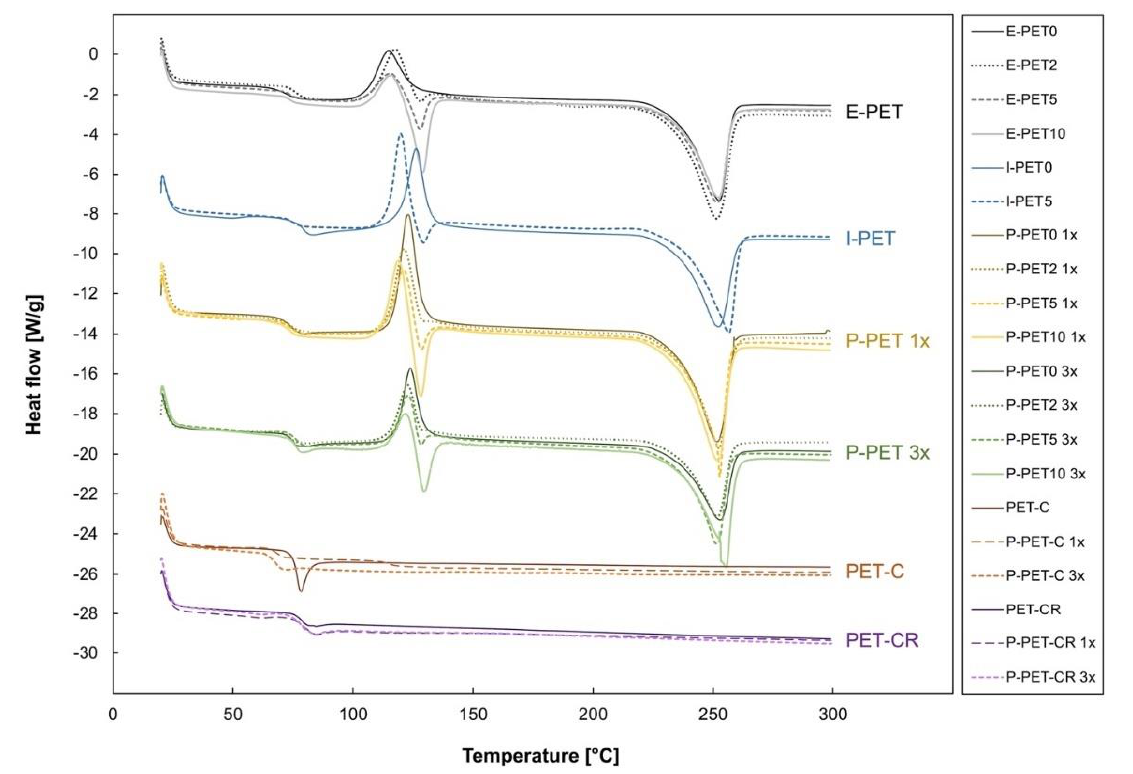
Figure 8. First heating thermograms of extruded, printed (single prints 1 × and three prints 3 × ), and injection molded PET filaments and samples with different levels of HDPE contamination and of virgin and recycled commercial PET, both extruded and printed. Table 4. Glass transition Tg, and melting point Tm, of HDPE and PET and crystallinity of PET in blends. Single prints are indicated as ‘1 × ’ and three prints as ‘3 × ’,